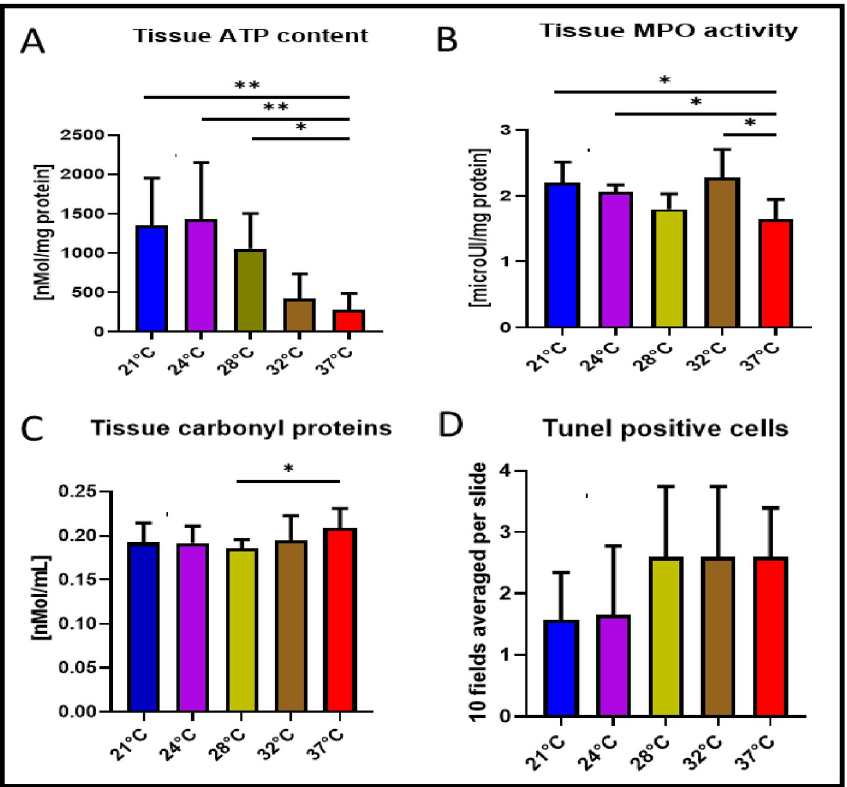
Fig 4. TUNEL assay, Myeloperoxidase activity, ATP and carbonylated protein content in lung tissues. (A) ATP content in lung tissue was significantly higher at 24˚C and 21˚C ( p < 0.01) or 28˚C ( p < 0 . 05 )versus ATP tissue content at 37˚C. (B) MPO activity in lung tissue after 4 hours of EVLP at 28˚C were close to the value at 37˚C, whereas significantly higher MPO activity were observed in tissue from EVLP performed at 21˚C or 24˚C and 32˚C ( p < 0 . 05 ). (C) Carbonylated protein level was significantly lower at 28˚C ( p < 0 . 05 )versus lung tissue exposed to 37˚C EVLP. (D) TUNEL analysis in histological preparation of lung tissue showed lower but not statistically different values towards less apoptotic cell damage in subnormothermic temperature of 24˚C and